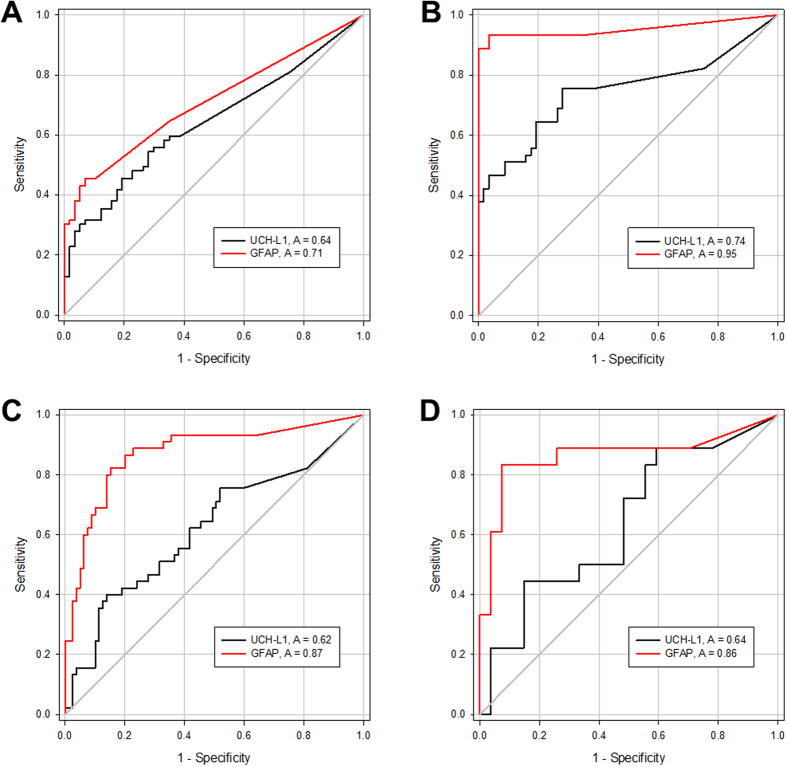
ROC curves for UCH-L1 (black line) and GFAP (red line) in serum for distinguishing patients with IS (A) and ICH (B) from controls, and for differentiating between patients with IS and patients with ICH at various time points (C) and within 4.5 hours of symptom onset (D).The area under the curves is indicated.